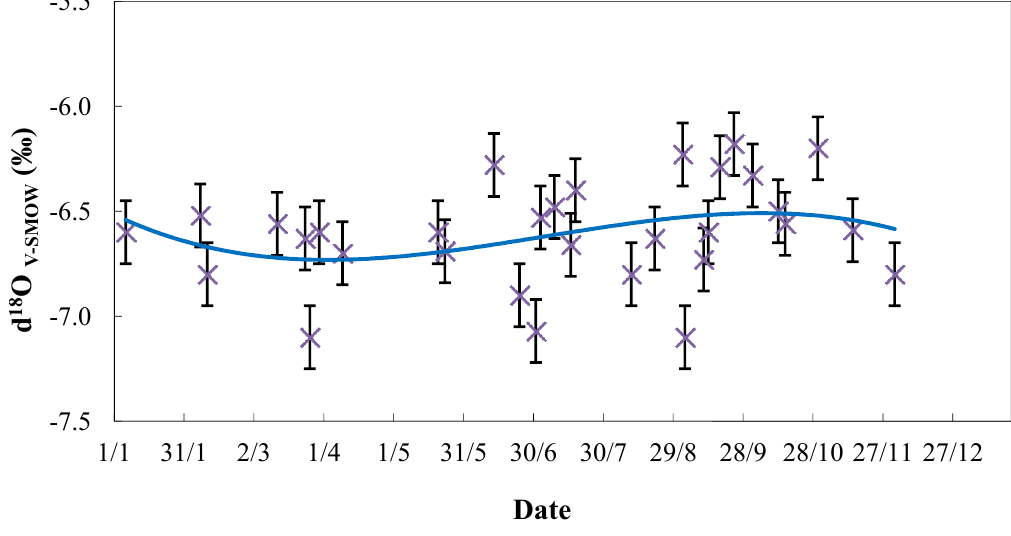
Figure 4. Variation of the δ 18 O values of the reference groundwater well near Verdun sur Garonne (between 1997 and 2003) over the season. The solid line represents the polynomial regression